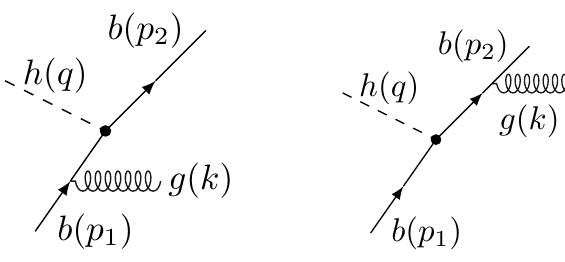
Figure 3 . Real-emission contributions to Higgs boson scattering off a b quark at O ( α s ) . For the calculation in the massive scheme we keep p 2